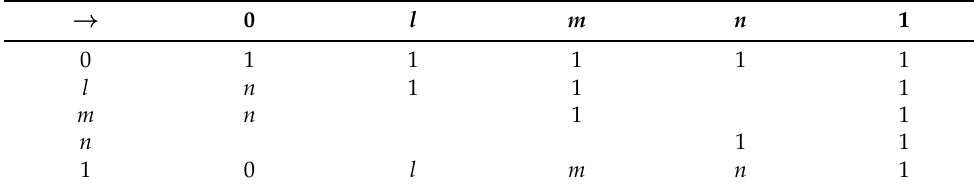
Table 14. The partial operation → . →